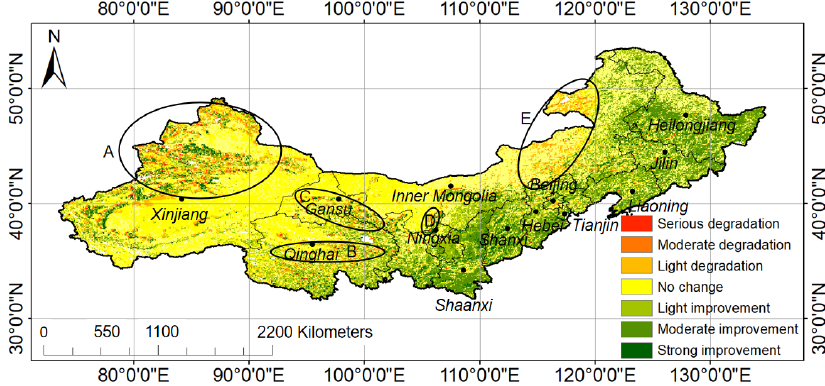
Figure 4. Change of NDVI from 1982 to 2018. (Regions A, B, C, D, and E are regions with degraded